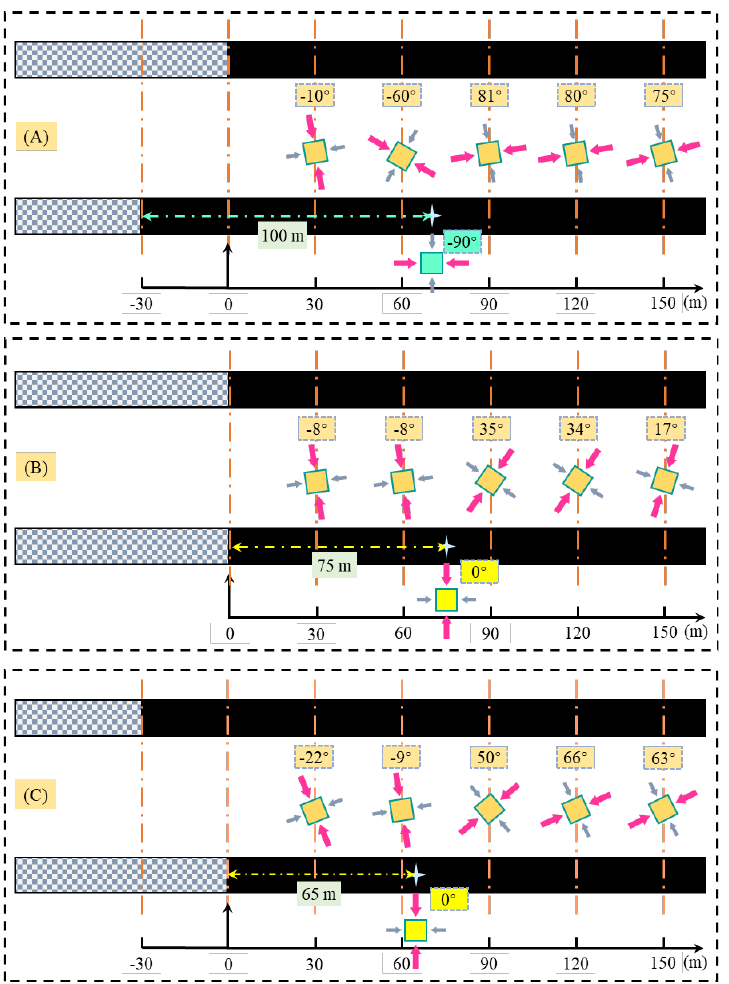
Figure 9. Deflection law of the principal stress in front of the different layout modes of the upper and lower coal seams. ( A ) External-offset of 30 m. ( B ) Overlapping arrangement. ( C ) Internal-offset of 30 m.